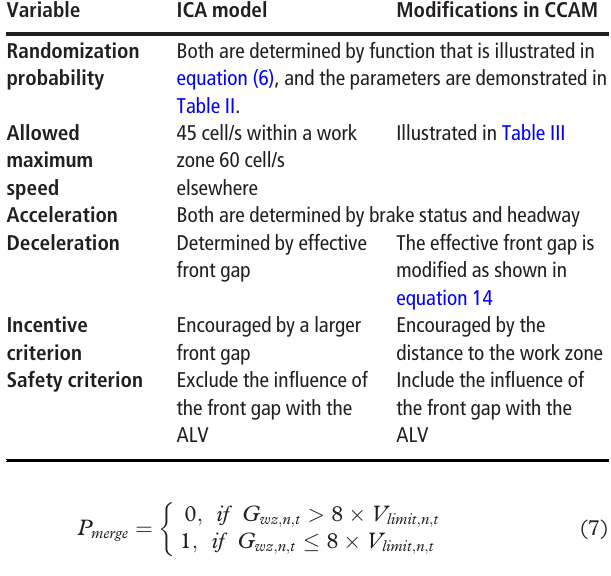
Table I Comparison between ICA and modi fi ed ICA Variable ICA